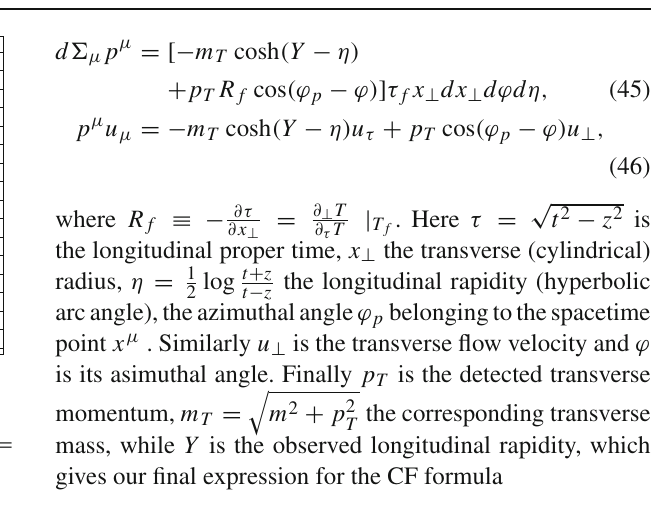
estimate the transverse momentum spectrum emerging from the Magneto-hydrodynamic solutions.